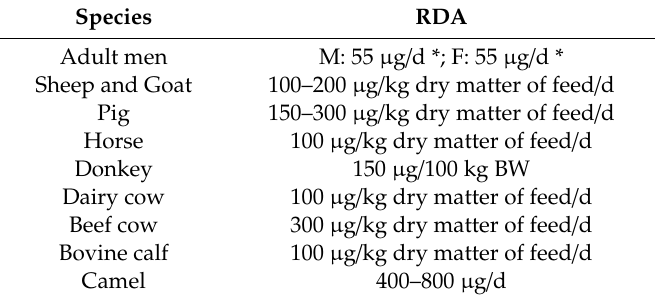
Table 2. Recommended dietary allowances (RDAs) of selenium for humans and various animal species (values adapted from Qazi et al. 2018